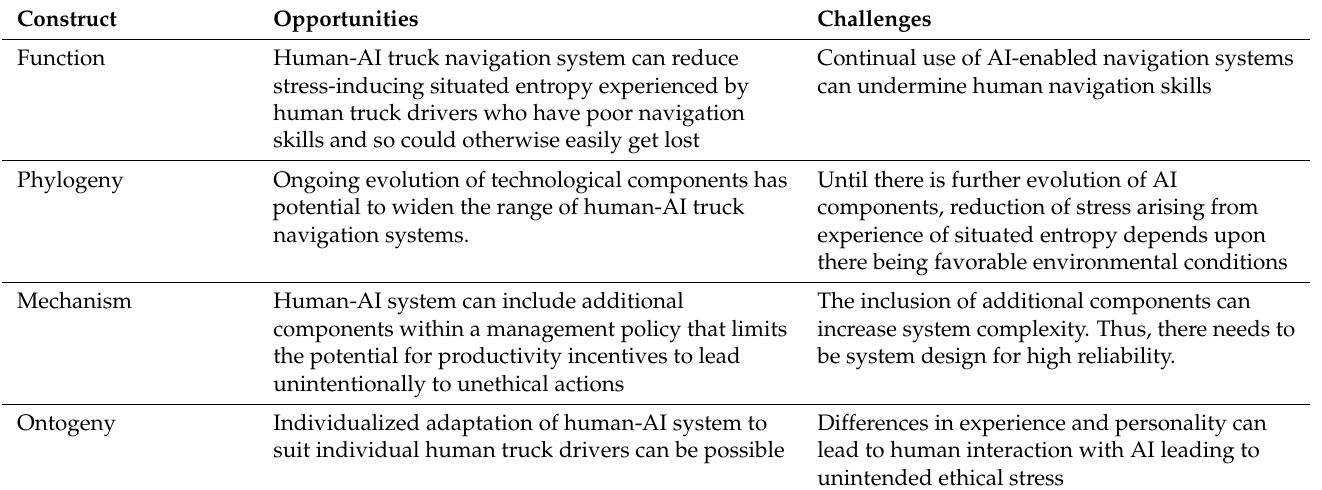
Table 5. Vehicle navigation example of opportunities and challenges for behavioral ethics in human- AI